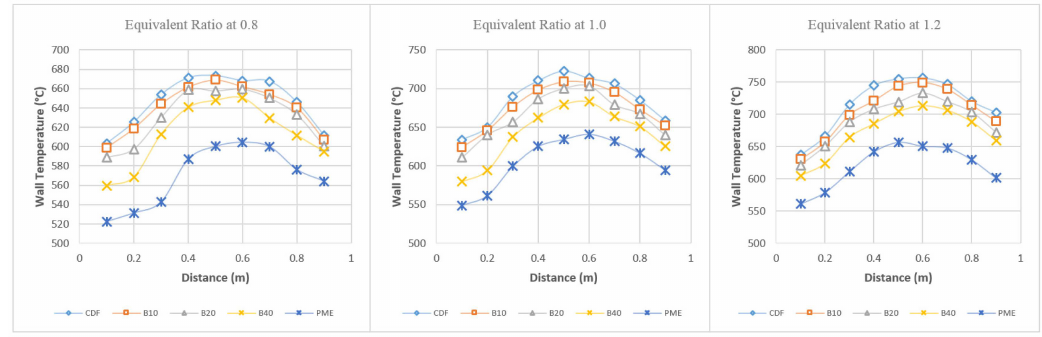
Figure 5. Wall temperature profiles for the 1.50